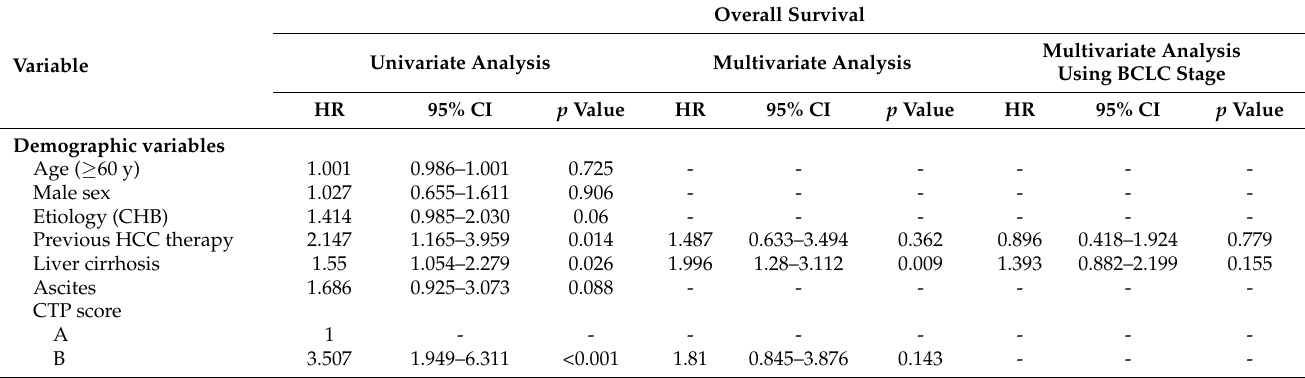
Table 3. Factors contributing to overall survival.